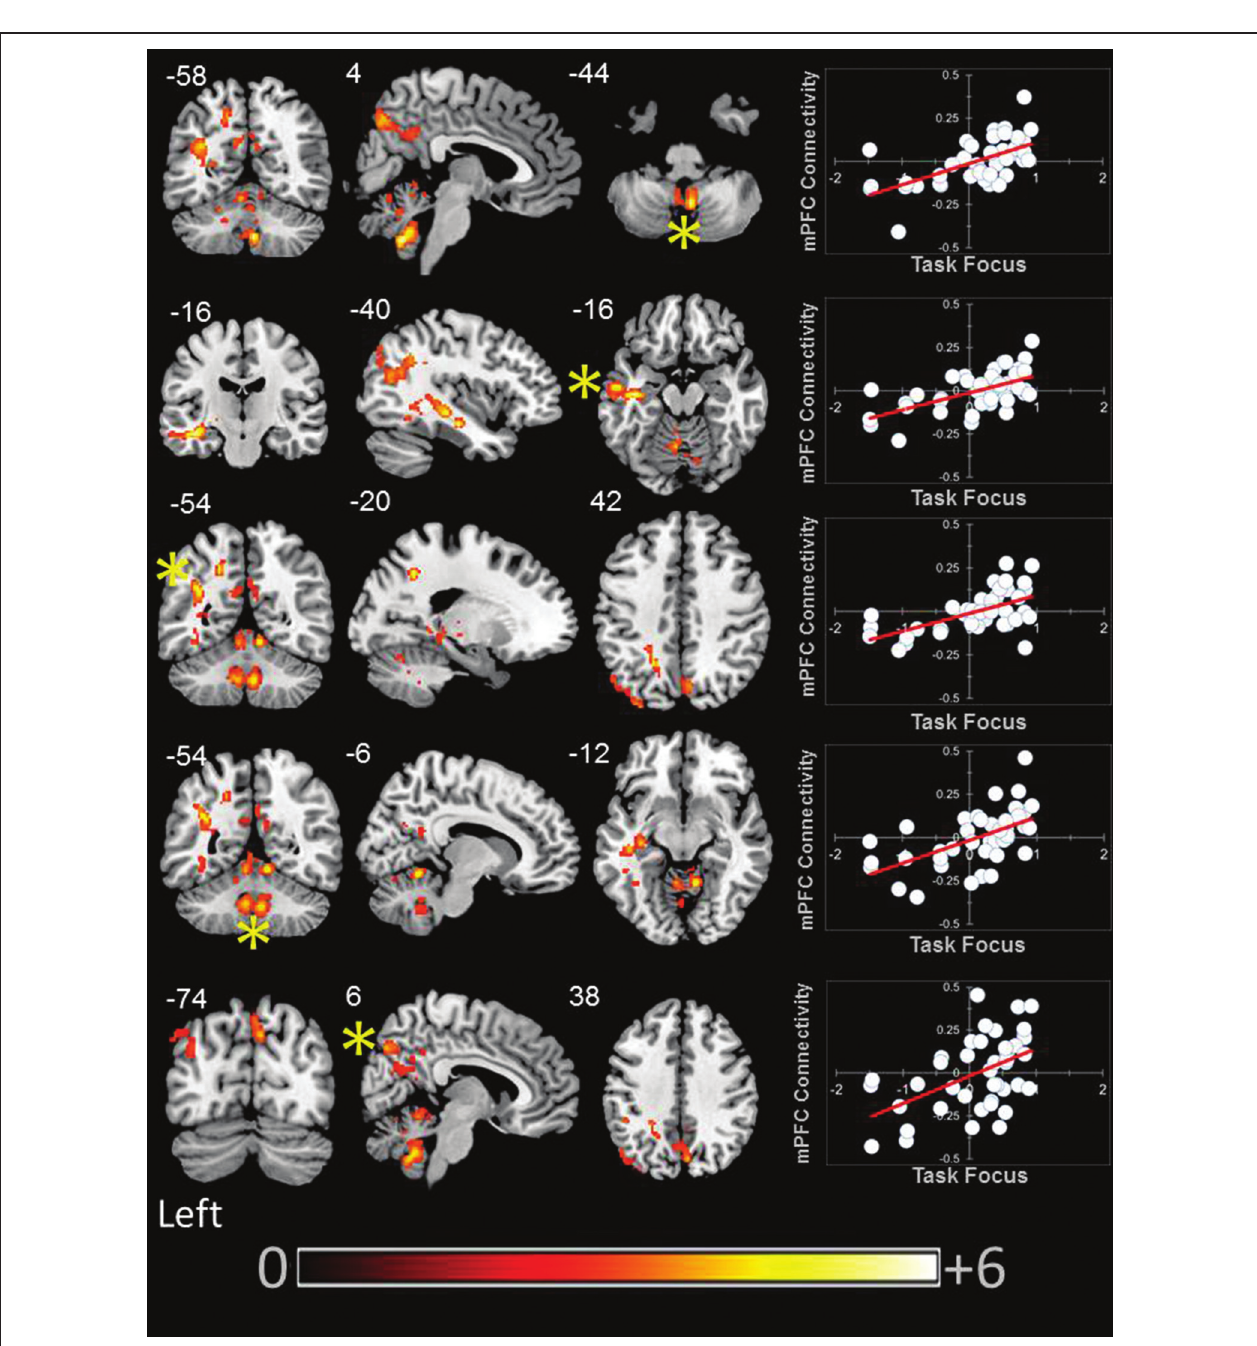
aMPFC for the peak voxel in each cluster. Each point is a single individual. Co-ordinates reflect the peak voxels for each cluster. All results are overlaid on a standard MNI template. Unthresholded statistical maps have been uploaded to NeuroVault.org and are available at